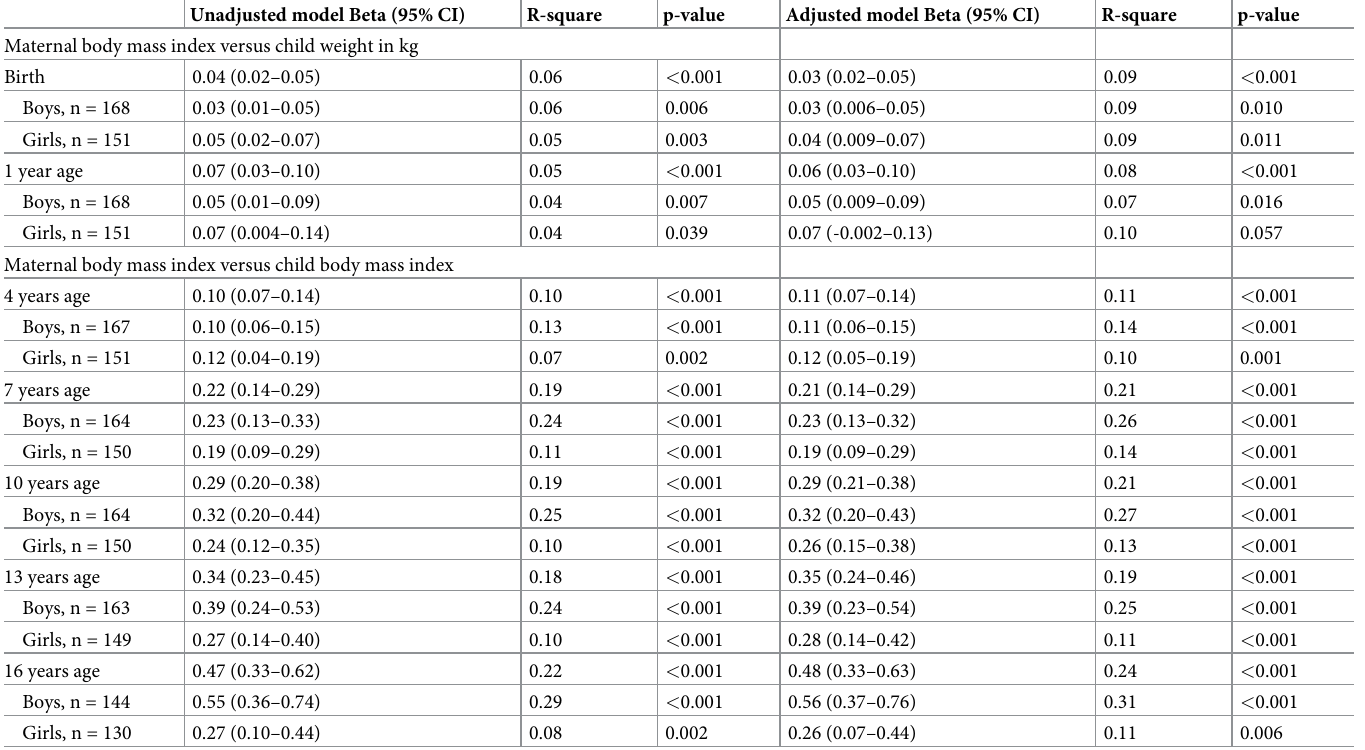
Table 2. Association between maternal body mass index in early pregnancy and child weight at birth and 1 year, and child body mass index at 4, 7, 10, 13 and 16 years for the entire study population and for boys and girls separately. Unadjusted model Beta (95%